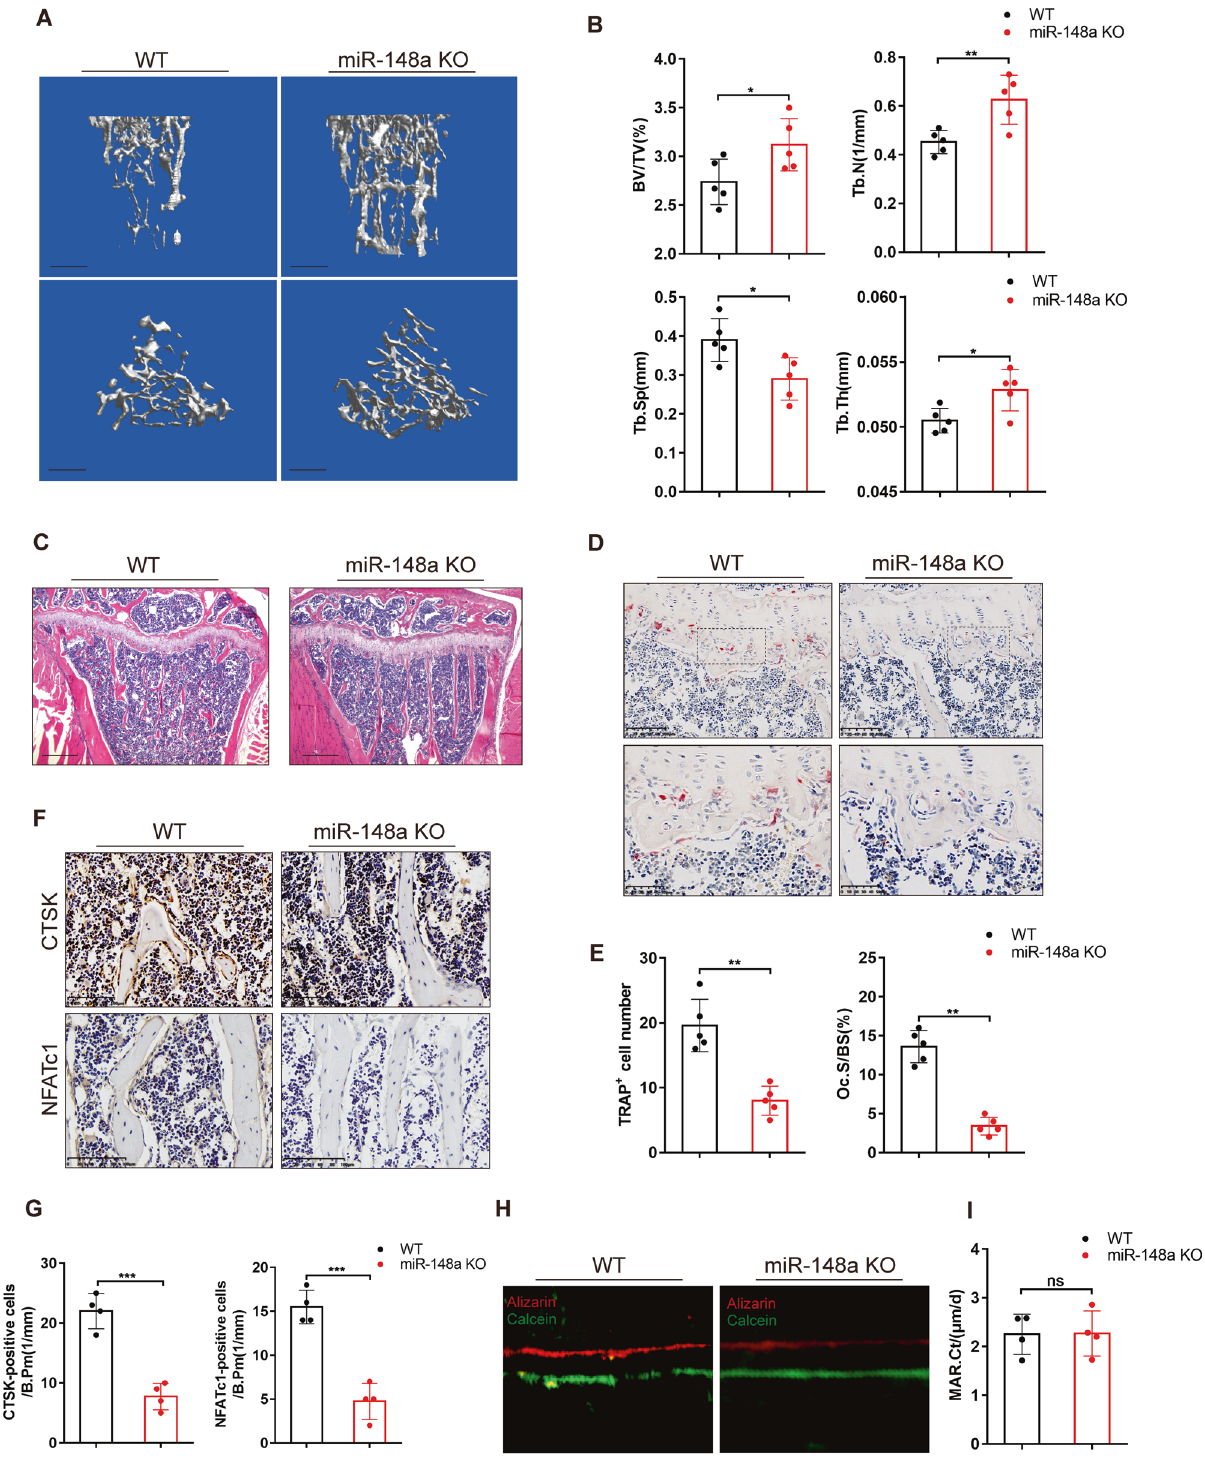
Fig. 1 miR-148a knockout increased bone mass in mice under physiological conditions. A Representative 3D reconstructive microcomputed tomography ( μ CT) images of tibiae; Scale bar, 1 mm. B Quantitative analysis of the trabecular bone of 16-week-old female KO and WT mice; n = 5. C Representative H&E staining images of decalci fi ed tibial bone sections from WT and KO mice; Scale bar, 500 μ m. D Representative TRAP staining images of decalci fi ed tibial bone sections from WT and KO mice; Scale bar, 100 μ m. E Quantitative analysis of the number of TRAP-positive cells and the osteoclast surface/bone surface (Oc.S/BS); n = 5. F The expression of NFATc1 and CTSK in decalci fi ed tibial bone sections from WT and KO mice, as detected by immunohistochemical staining; Scale bar, 100 μ m. G Quantitative analysis of the number of positive cells in F ; n = 4. H Representative images of calcein-alizarin red double fl uorescent labeling demonstrated bone formation in mouse femur from 16-week-old female KO and WT mice; Scale bar, 5 μ m. I Quantitative analysis of cortical bone mineral apposition rate (MAR) in H ; n = 4. (All data are presented as mean ± SD; * p < 0.05; ** p < 0.01; *** p < 0.001; ns no signi fi cance; compared to the littermate control group). Cell Death Discovery (2022)